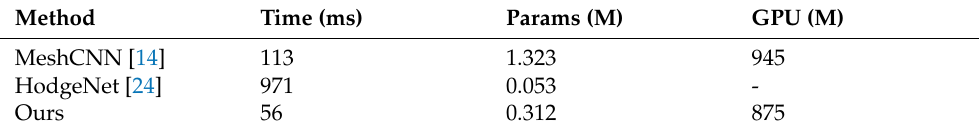
Table 8. Time and space complexity for SHREC11 Split